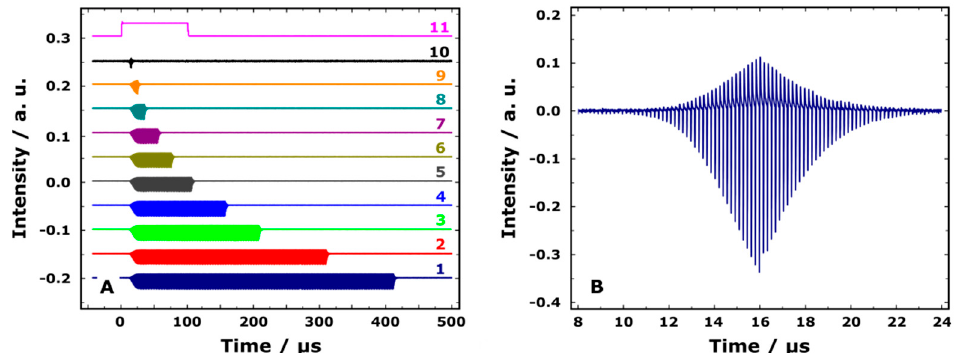
Figure 6. ( A ) Macropulses of THz radiation with wavenumber of 76.7 cm − 1 . Macropulse durations are (1) 400 µ s, (2) 300 µ s, (3) 200 µ s, (4) 150 µ s, (5) 100 µ s, (6) 70 µ s, (7) 50 µ s, (8) 30 µ s, (9) 20 µ s, (10) 10 µ s (multiplied by 10 in intensity), (11) trigger signal. Each subsequent pulse is vertically shifted. ( B ) Macropulse with 10 µ s duration. The individual pulses of THz radiation with the repetition frequency of 5.6 MHz are clearly visible.